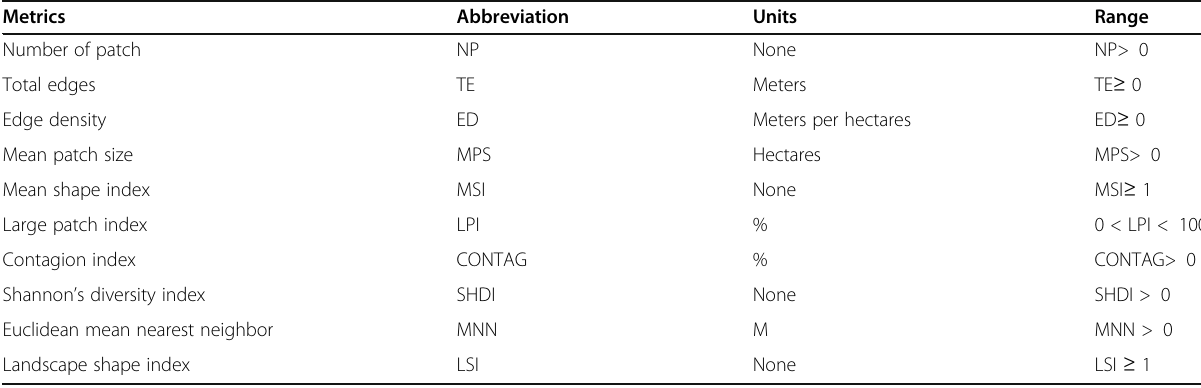
Table 2 Metrics used at the class and landscape levels to analyze the distribution of the suitable habitat of Amygdalus scoparia in different classes of landform (McGarigal